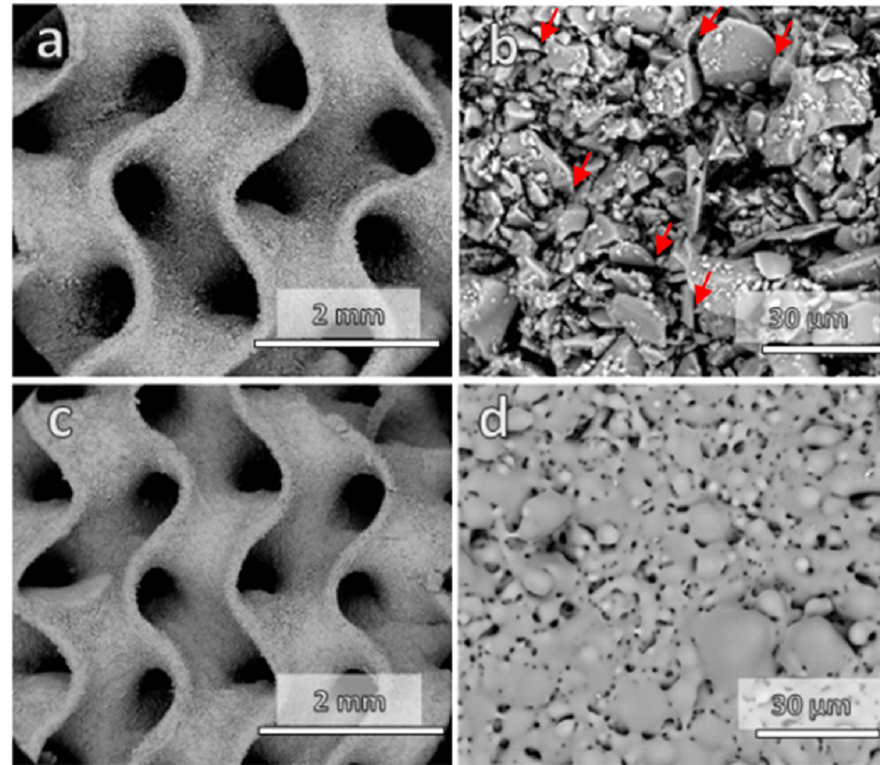
Figure 2. Microstructural details of gyroid scaffolds: ( a , b ) after firing at 680 °C; ( c , d ) after firing at 730 °C.